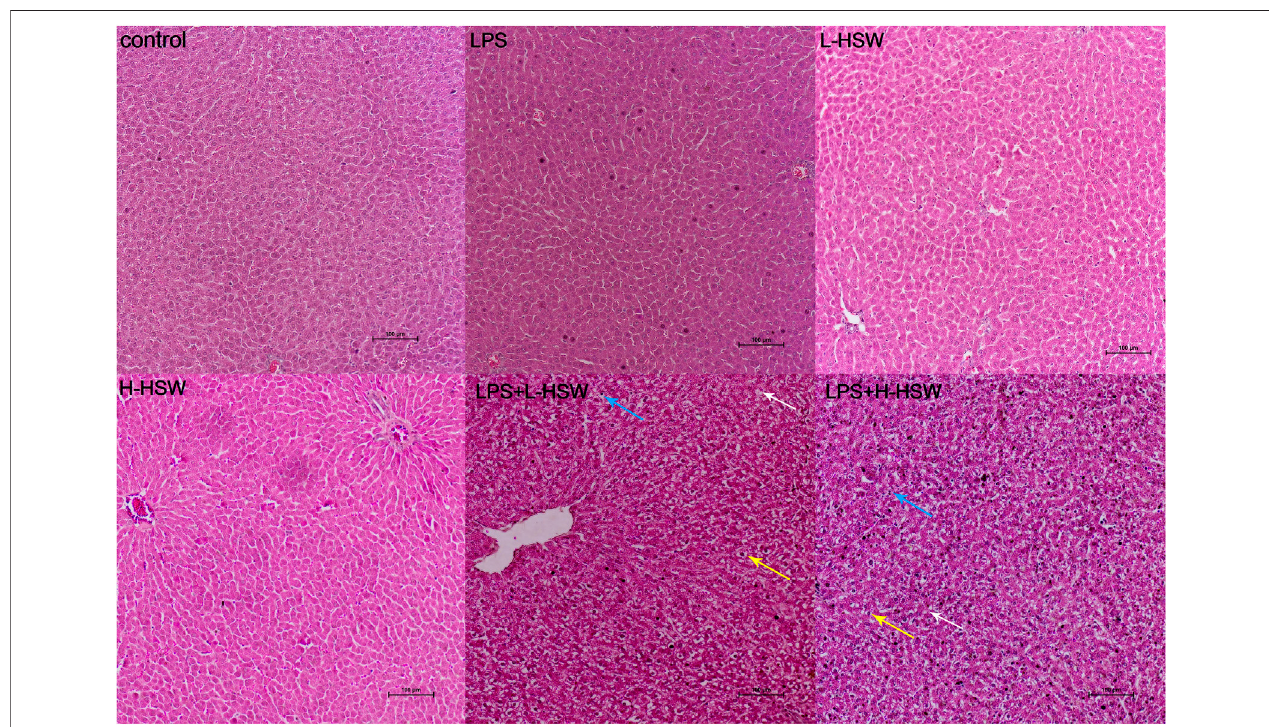
FIGURE 4 | Representative histopathological microphotographs of rat liver. Rats were treated with saline (control), 2 mg/kg dose of LPS (LPS), 2 g/kg/day HSW (equivalent of raw herb, L-HSW), 10 g/kg/day HSW (equivalent of raw herb, H-HSW), 2 mg/kg LPS plus 2 g/kg/day HSW (equivalent of raw herb, LPS + L-HSW), and